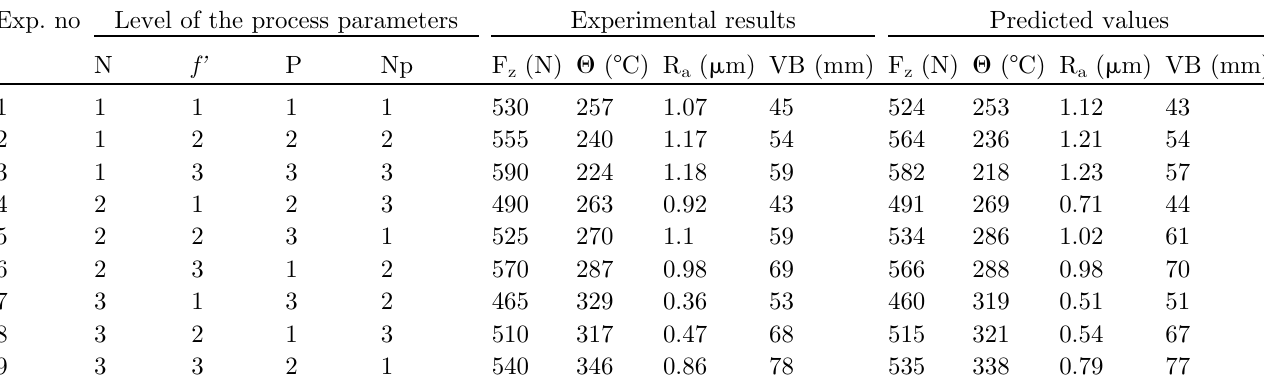
Table 4. Experimental results predicted values of responses under nano fl uid mixed MQL condition using AlCrN coated carbide drill.